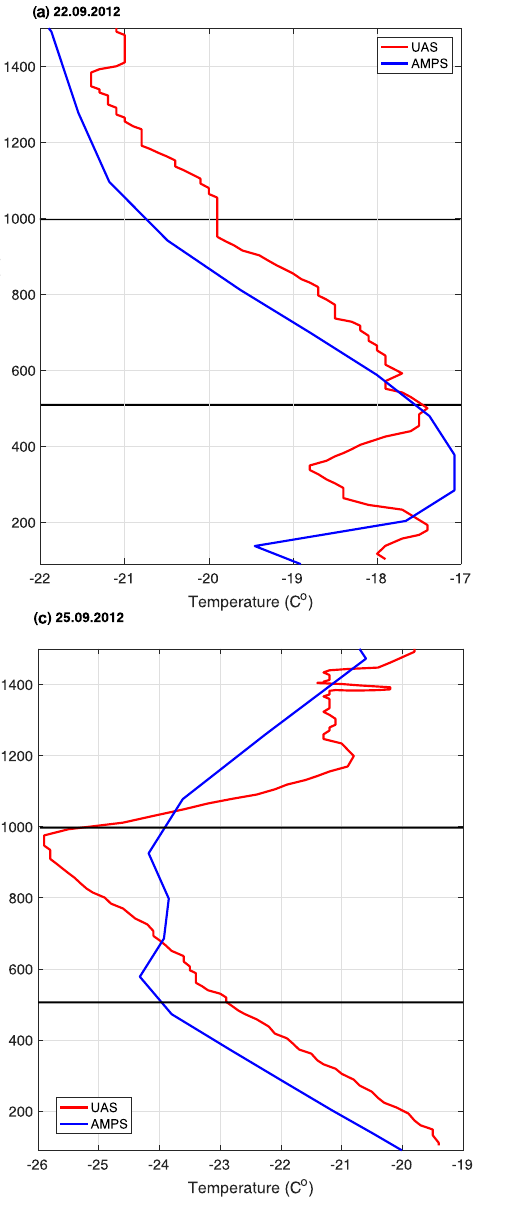
Figure 14. Exemplary profiles from UAS Aerosonde observations and AMPS model results. ( a , b ) Profile nr 3, 22.09.2012. ( c , d ) Profile nr. 4,